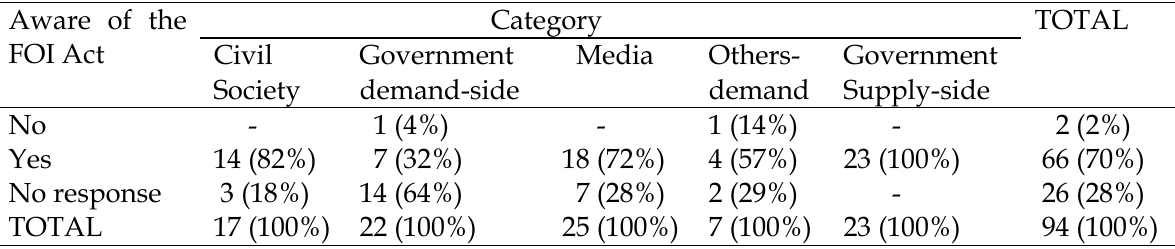
Table 2: Awareness of the FOI Act Aware of